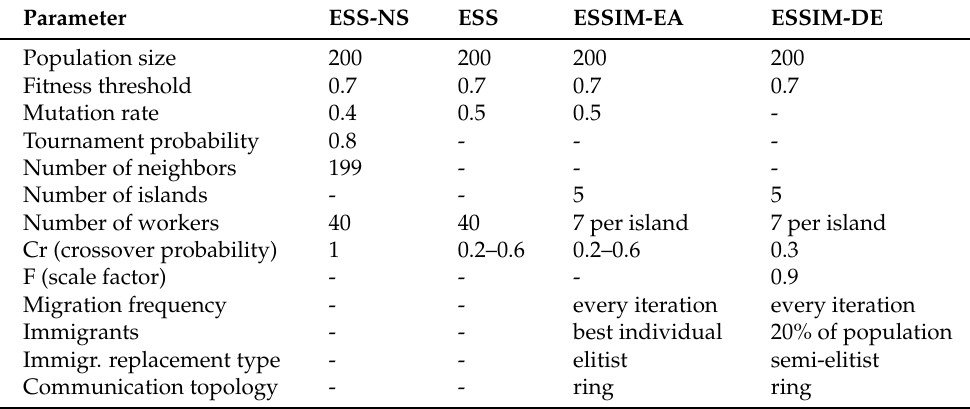
Table 3. Parameters used for each method in the experimentation. Parameter ESS-NS Population size